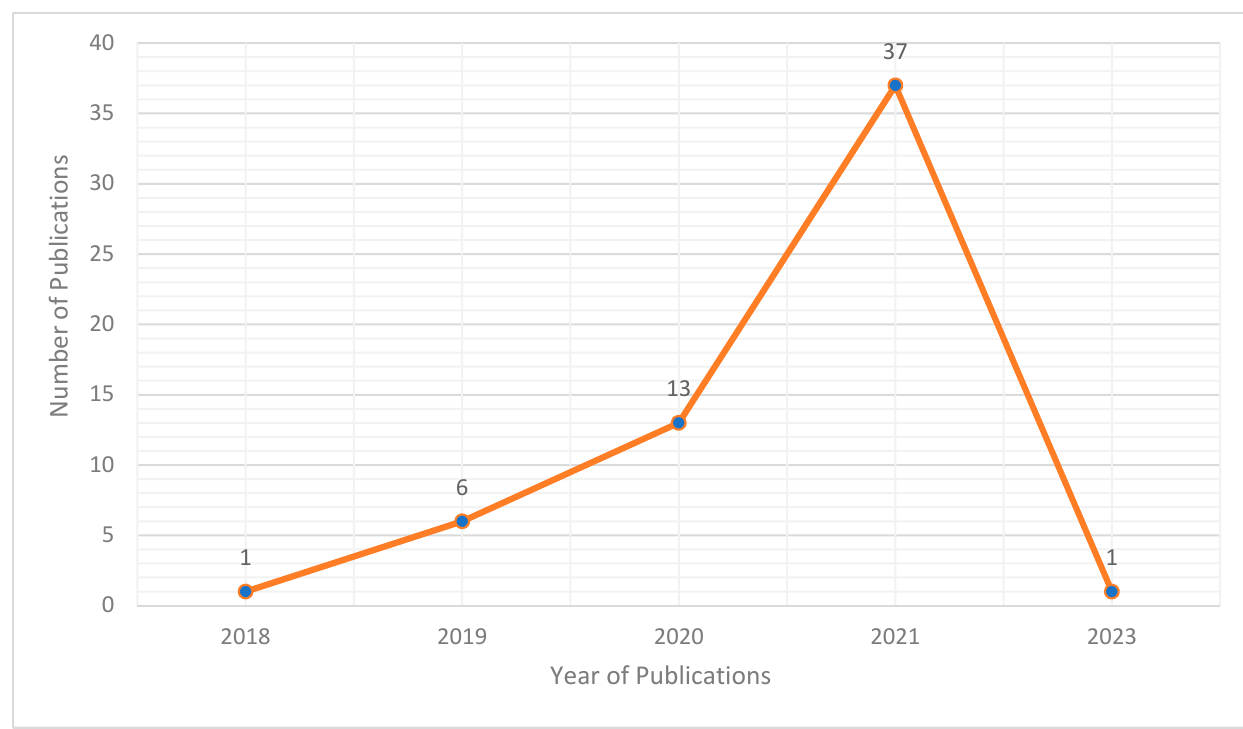
Figure 2. Number of relevant publications published annually from 2018 to 2023.